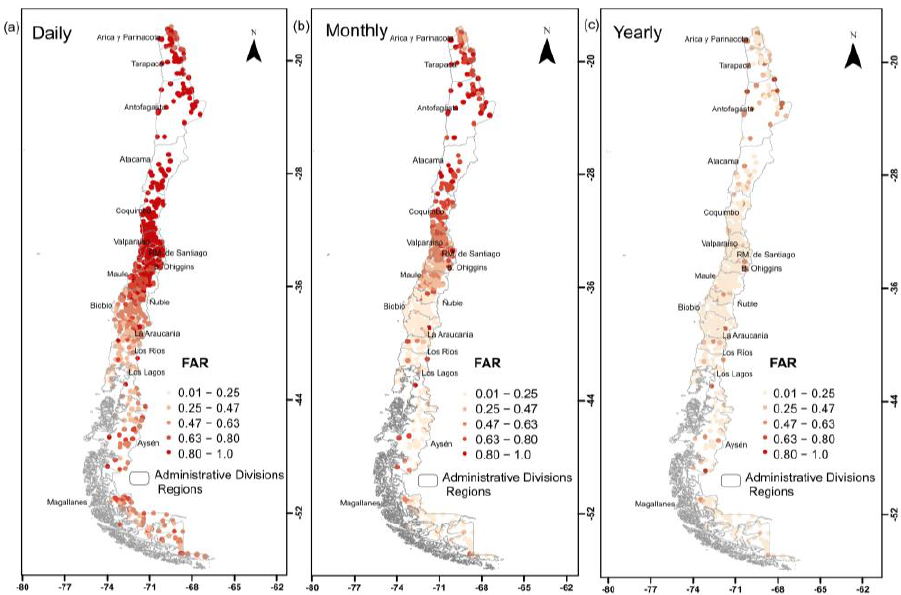
Figure 8. Daily, Monthly, and Yearly FAR for IMERG Early product.